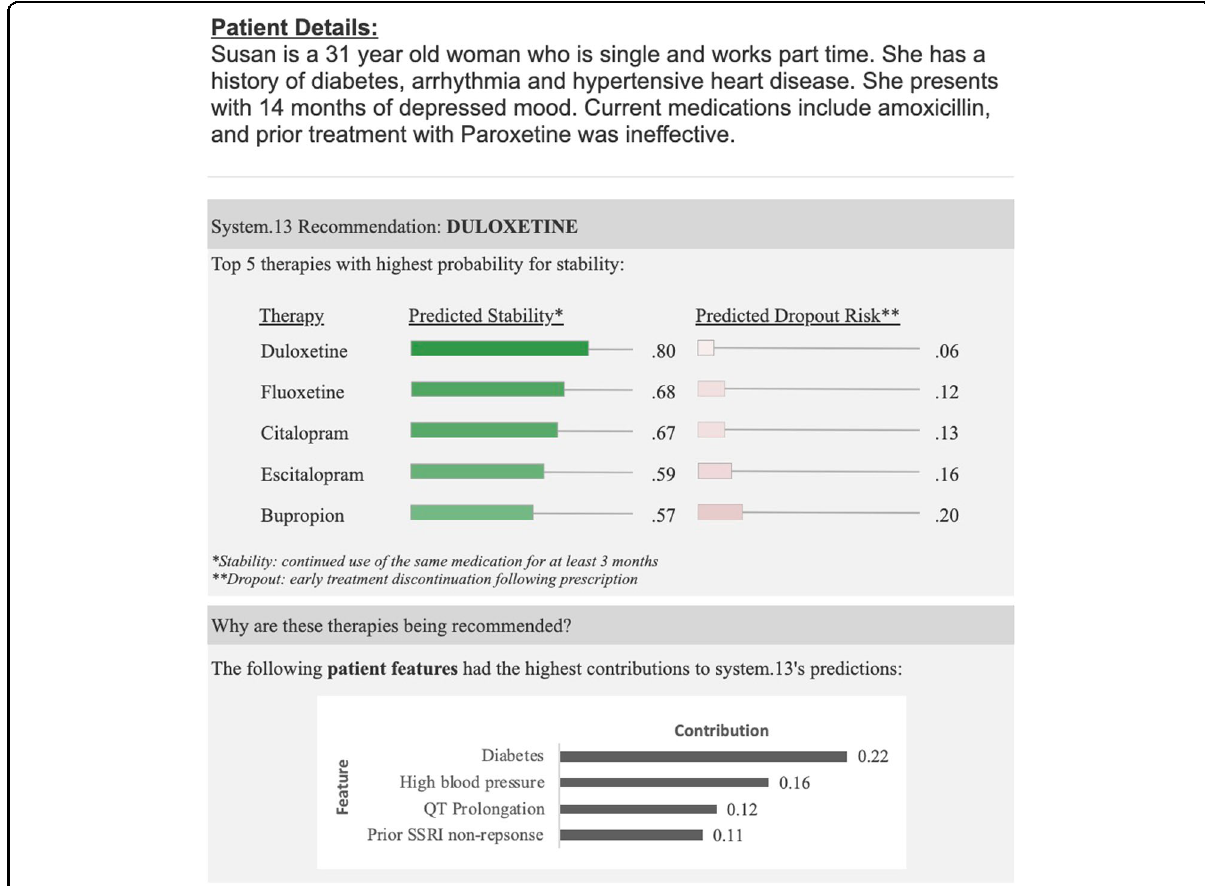
Treatment selection con fi dence . In each vignette, after selecting a treatment, participants were asked “